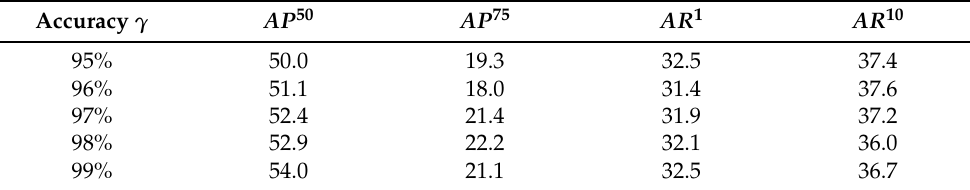
Table 5. Comparison of test results of different